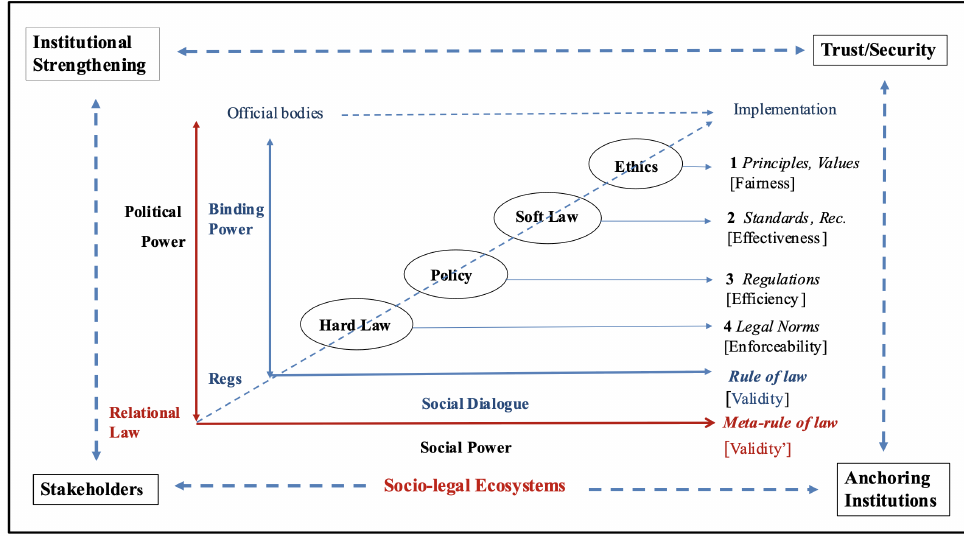
Figure 1. A general scheme for the meta-rule of law (Source: Poblet et al.